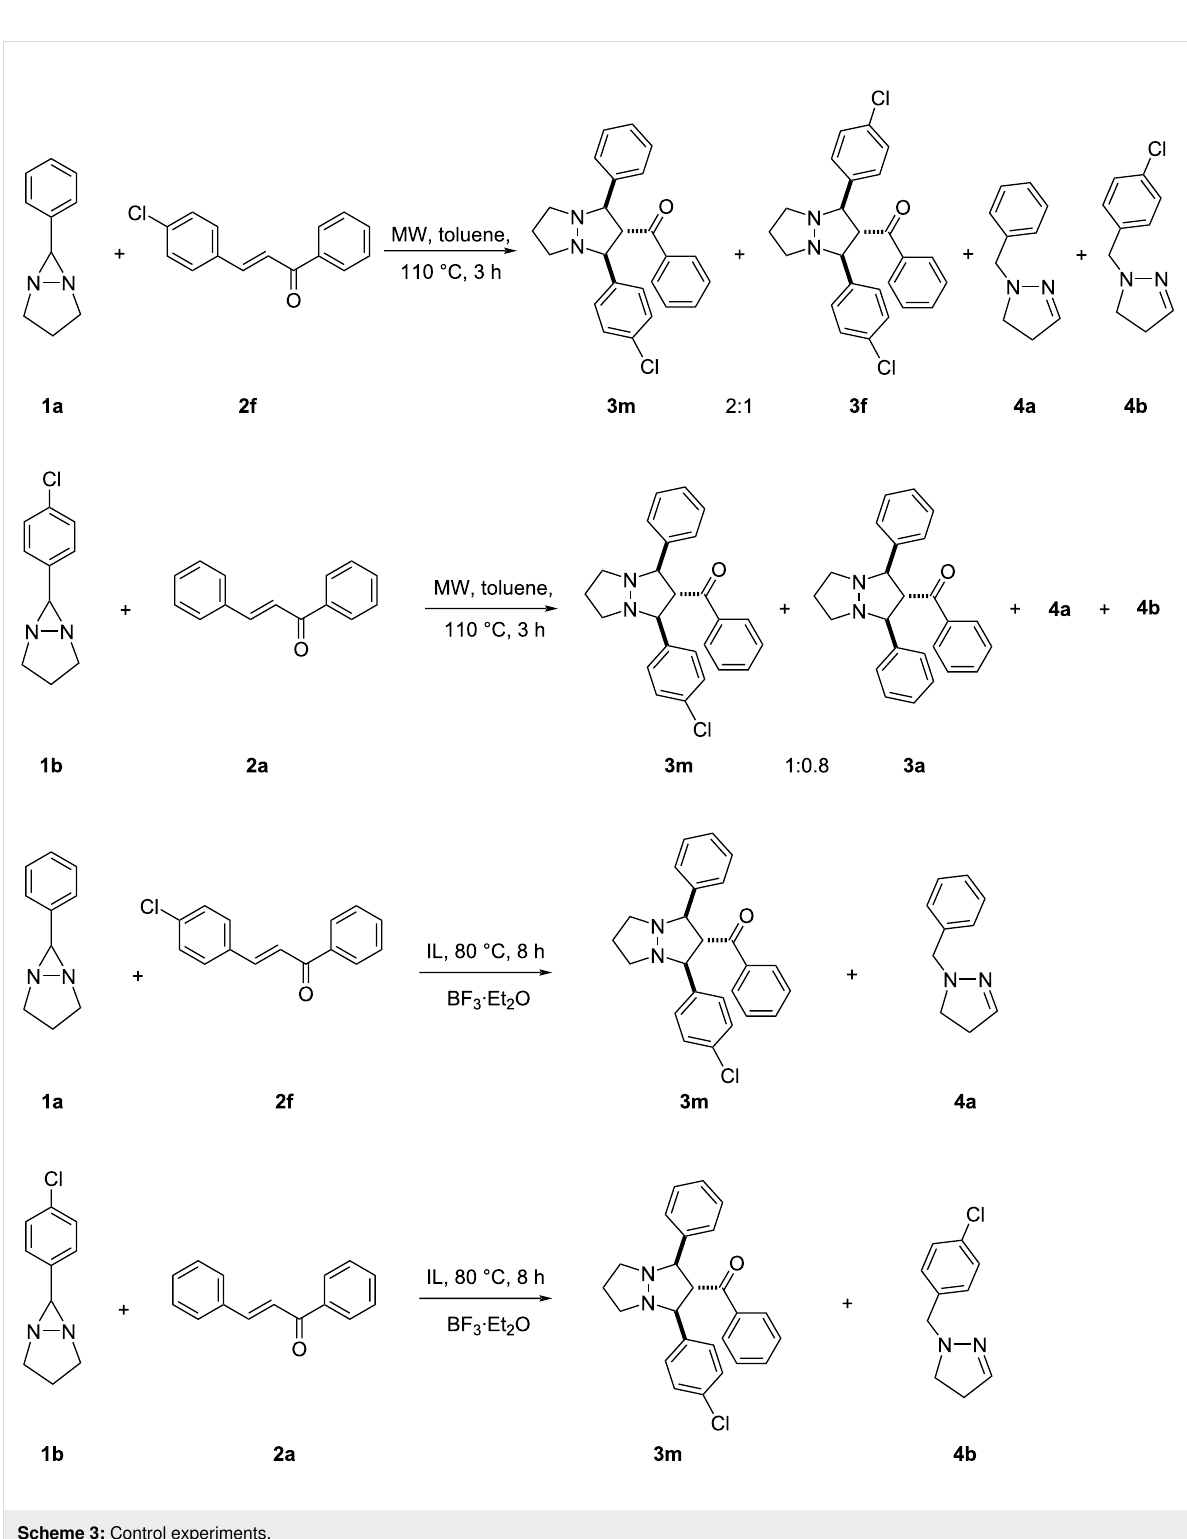
Scheme 3: Control experiments.